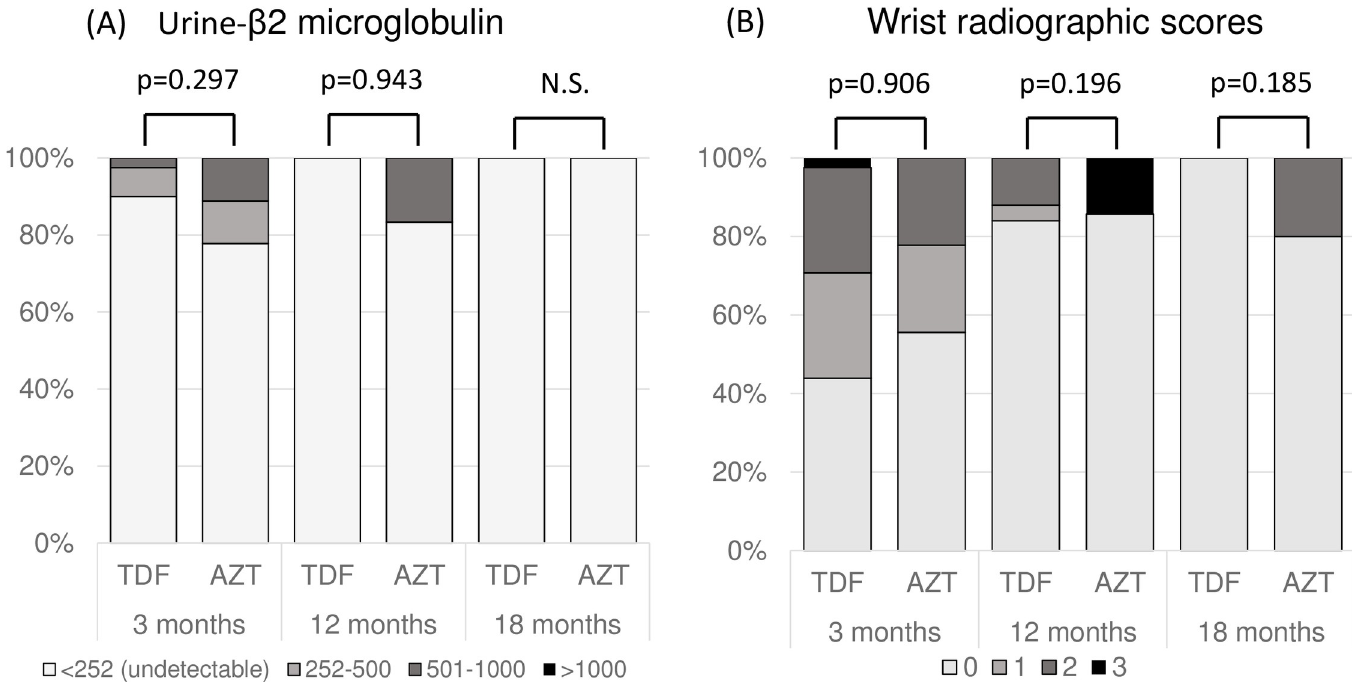
Fig 3. Comparison of the prevalence of elevated urine β 2-microglobulin (A) and abnormal radiographic wrist score for rickets (B) between the TDF and AZT groups. Data were compared by chi-square test.